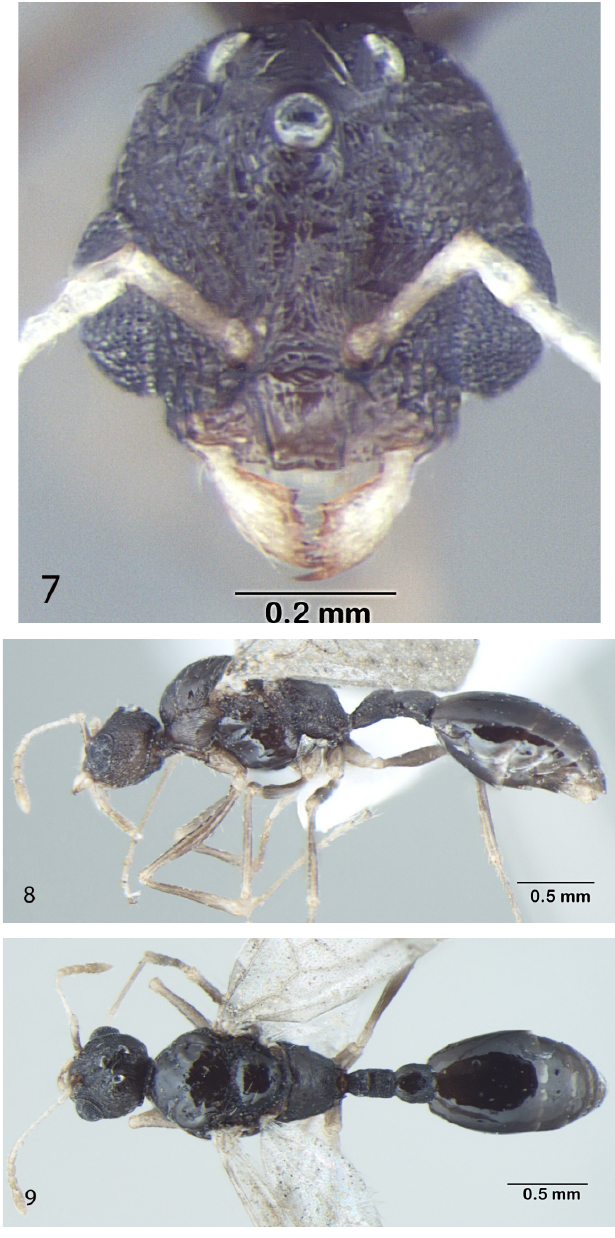
Figs 7-9. Male Temnothorax simlensis stat. nov.: 7- Head, full face view; 8- Body, lateral view; 9- Body, dorsal